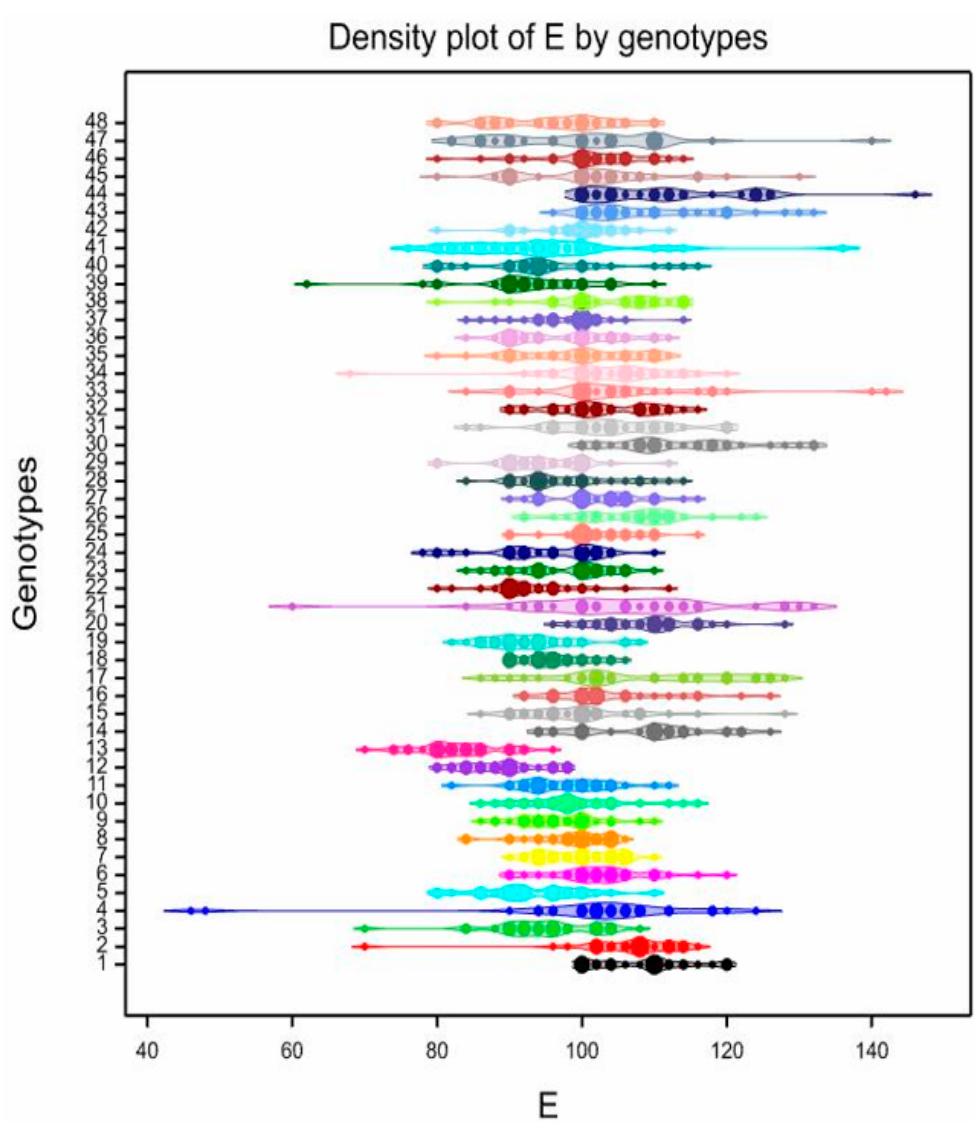
Figure 6. The density plot for the distribution of the mean length of the equatorial diameter (E), classified by Abies alba genotypes. Numbers from 1 to 48, see Table 1. Generally, the mean P / E ratio was 0.84 and ranged from 0.44 in genotype 44 to 1.83 in genotype 4. On average, the smallest value of the P / E ratio was in genotype 1 (0.78) and the largest in genotype 39 (0.91). The largest range of P / E ratio was found in genotype 4 (0.65–1.83) and the smallest one in genotype 28 (0.71–0.92) (Table 3, Figure 7). In all the genotypes of A. alba , suboblate (50.83%), oblate-spheroidal (23.82%), and oblate (19.38%) pollen shape classes predominated. Rarely, prolate-spheroidal (3.40%) and spheroidal (1.94%) were noted. In seven pollen grains (0.49%) and two other (0.14%), subprolate and peroblate shapes were found,